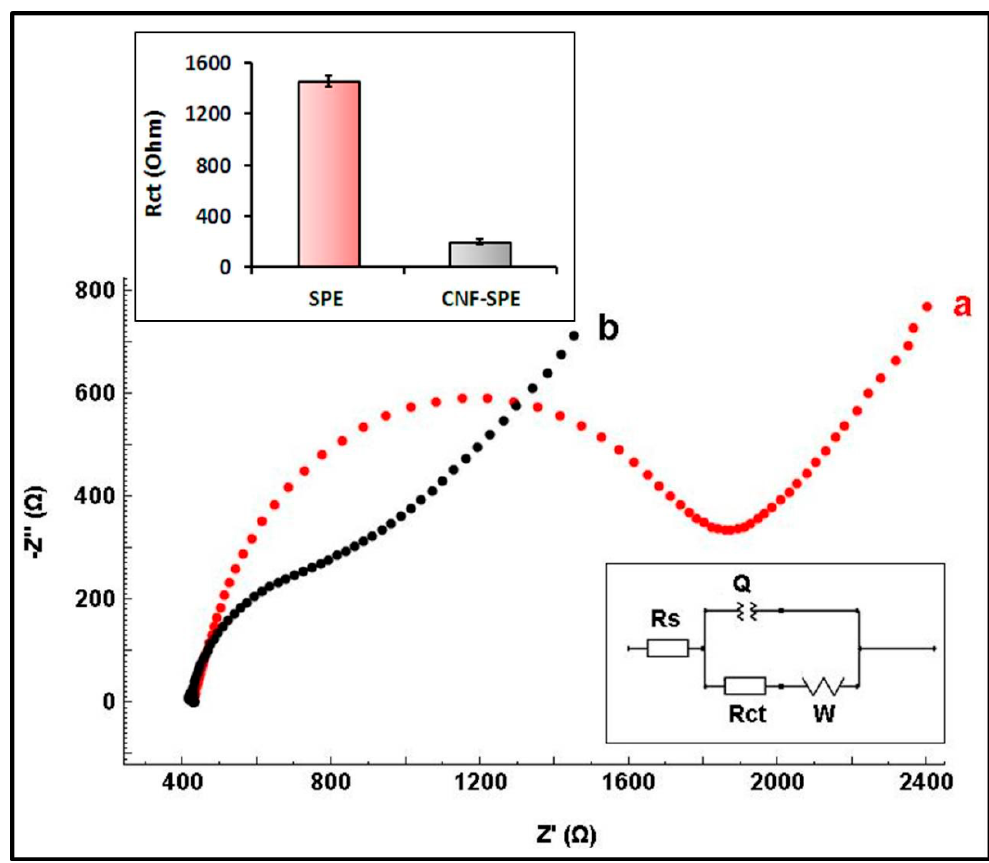
Figure 3. Nyquist diagrams of ( a ) SPE, ( b ) CNF-SPE. Inset: Histograms representing the average R ct values recorded by ( a ) SPE, ( b ) CNF-SPE.